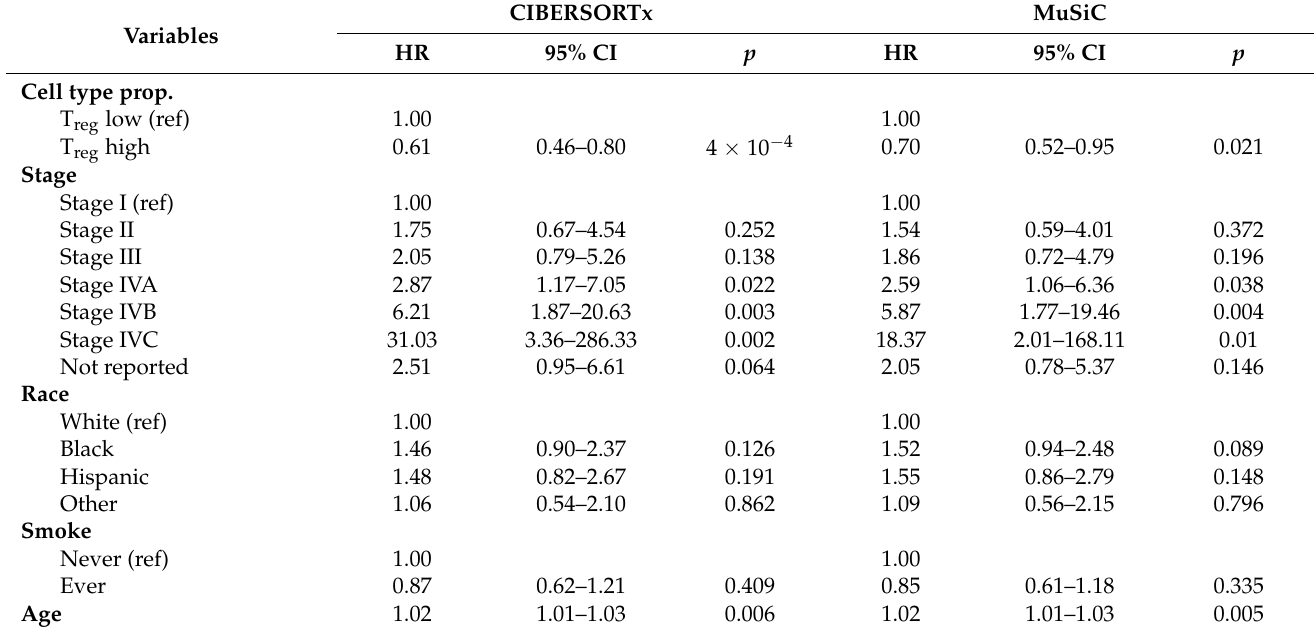
Table 3. Cox proportional-hazard regression analysis for survival and T reg proportions estimated by CIBERSORTx and MuSiC (prop., proportion; HR, hazard ratio; CI, confidence interval; ref,